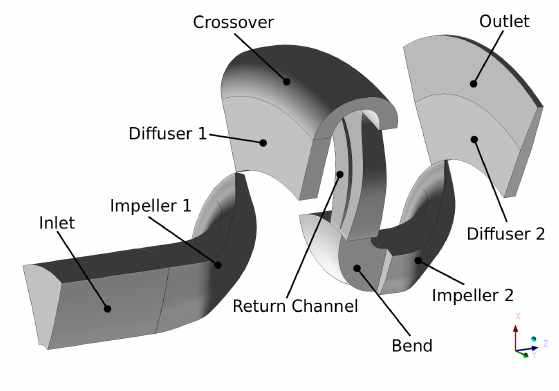
Figure 9. Parts Figure 9. Parts Overview